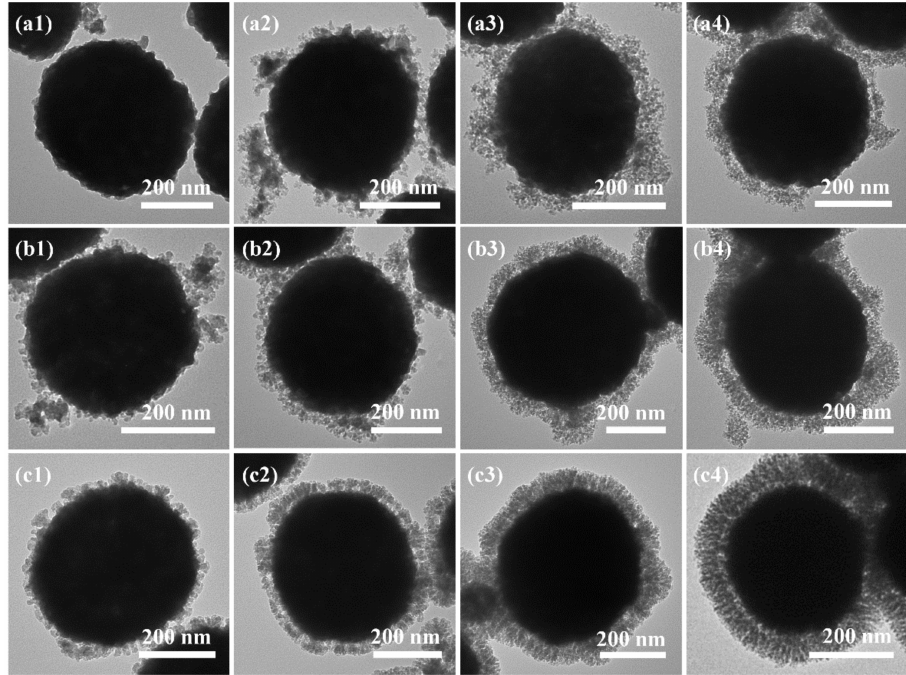
Figure 5. TEM images of the calcined BaSO 4 @APF-SiO 2 prepared with different shell growth time: 15 min ( a1 , b1 , c1 ), 30 min ( a2 , b2 , c2 ), 60 min ( a3 , b3 , c3 ), and 120 min ( a4 , b4 , c4 ). The a–c series of samples correspond to a TEOS addition of 0.545, 1.095, and 2.190 mL,